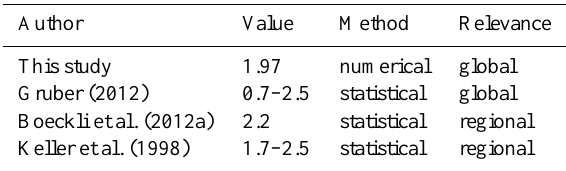
Table 3. Comparison of PE (km 2 × 10 3 ) obtained by this study compared to other methods in the